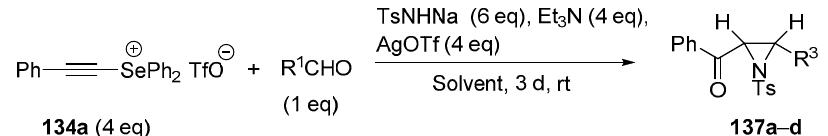
Table 11. Aziridines 137a – d obtained in the reaction of alkynylselenonium salt 134a with aromatic aldehydes and TsNHNa.